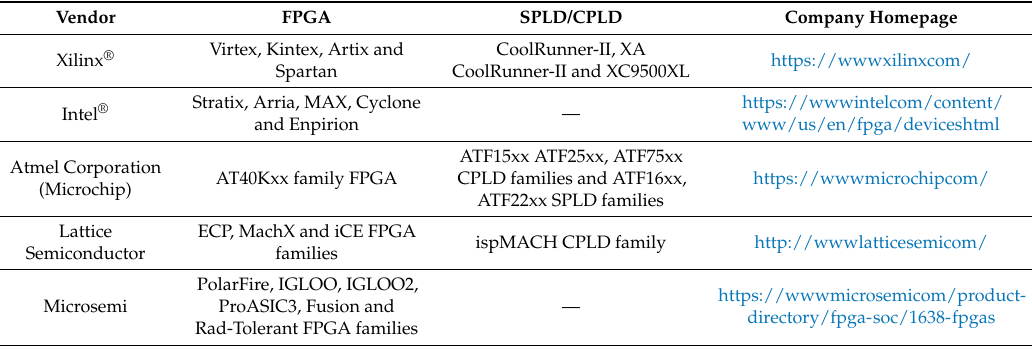
Table 2. PLD vendors and devices